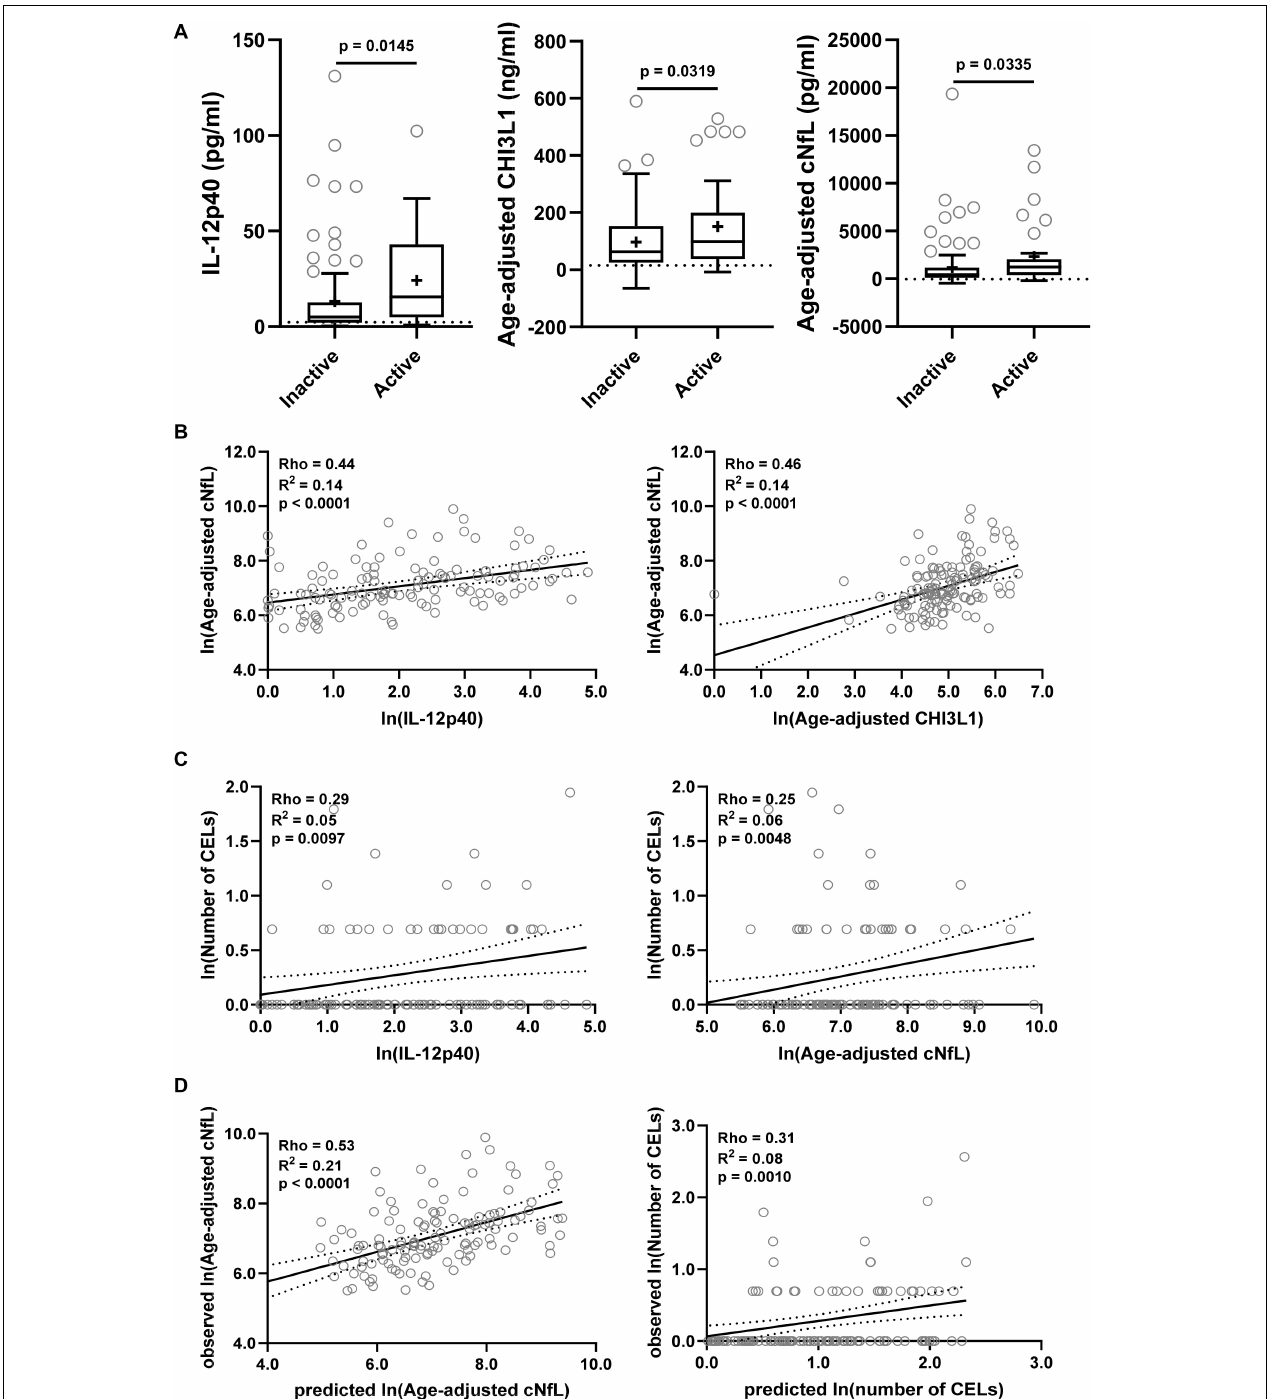
FIGURE 6 | The findings from the training cohort with a stronger statistical effect ( p < 0.01; IL-12p40, CHI3L1, and cNfL) were then validated in an independent validation cohort. (A) Biomarker concentrations were compared across lesional activity subgroups (inactive versus active, n = 96 and 34, respectively). Dotted line represents median of HDs and “+” sign represents mean of respective subgroup. (B) In MS patients ( n = 130) correlations between cNfL and IL-12p40, CHI3L1 were analyzed using Spearman analysis. Linear regression of IL-12p40 and CHI3L1 with cNfL as a dependent variable was analyzed. Solid line represents “line of best fit,” and dotted line represents 95% confidence intervals. (C) In MS patients ( n = 130) correlations between number of CELs and all biomarkers were analyzed using Spearman analysis; Only for statistically significantly (IL-12p40 and cNfL; p < 0.01) correlated biomarkers linear regression with number of CELs as a dependent variable was analyzed. (D) In validation cohort, the cNfL concentrations were predicted using combined linear regression model of IL-12p40 and CHI3L1 (from training cohort), and number of CELs were predicted using combined linear regression model of IL-12p40, CHI3L1 and cNfL. And then linear regression between predicted and observed values were